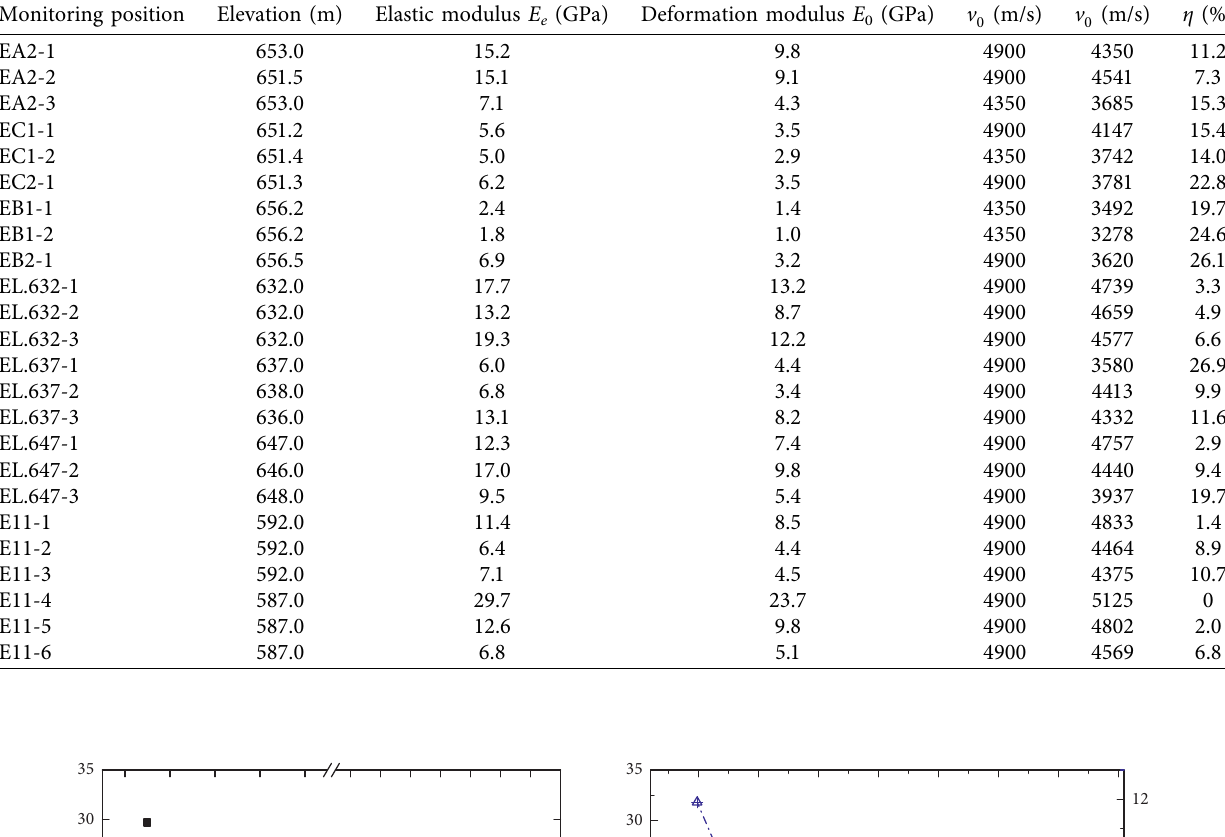
Table 1: Results of field tests at the left bank of the Baihetan hydropower station [43].